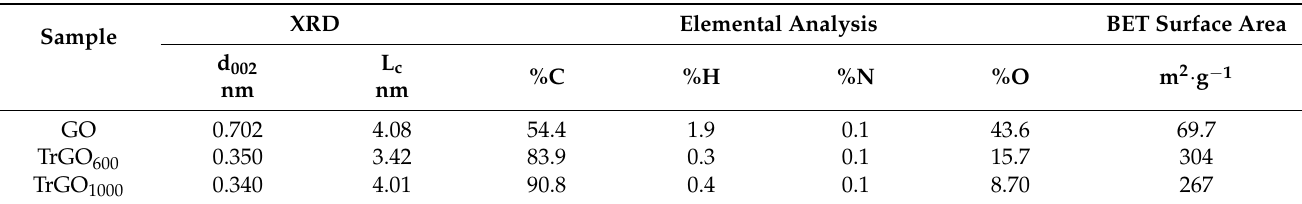
Figure 1. X-ray diffraction patterns of: ( a ) graphite, GO, TrGO 600 , and TrGO 1000 and ( b ) Fe 3 O 4 , Mb 600 , Mb 1000 , Ma 600 , and Ma 1000 . Table 1. Interlayer spacing (d 002 nm) and crystal size (L c nm), elemental analysis, and BET Surface area of GO, TrGO 600 , and TrGO 1000